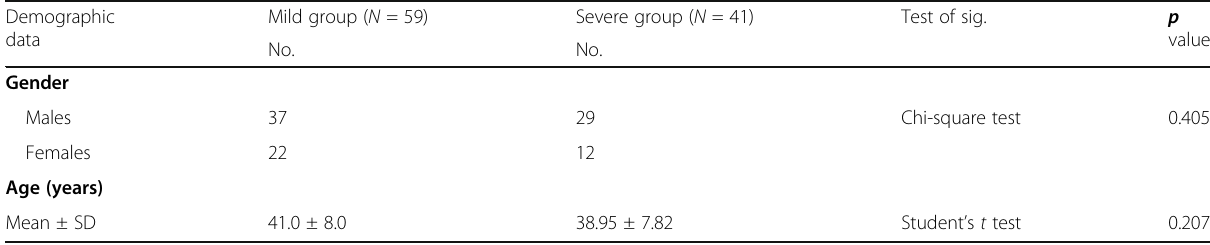
Table 1 Patients ’ demographic characteristics